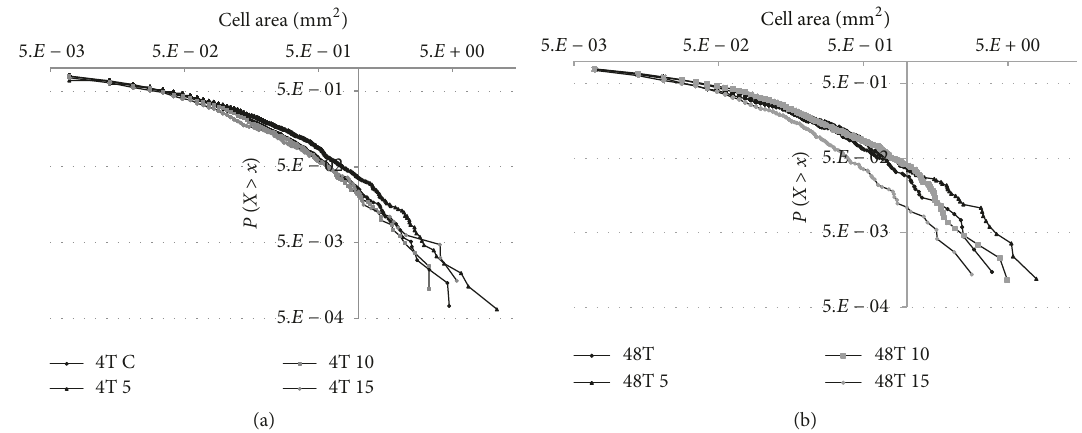
Figure 3: Complementary cumulative density function analysis in pan bread crumb made with semolina 4T (a) and semolina 48T (b).